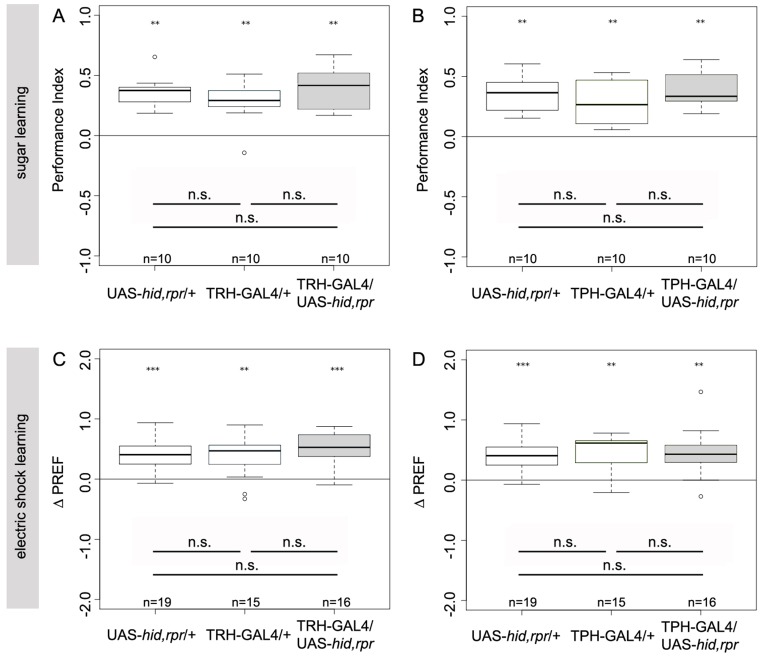
The Serotonergic Neurons of the CNS are not Necessary for Appetitive and Aversive Olfactory Learning.For testing appetitive olfactory learning, we utilized a two-group, reciprocal training design consisting of two half trials that give rise to a final performance index. Third instar larvae lacking serotonergic neurons preferred an odor that was paired with 2-M fructose (A, B). Using a single odor, non-reciprocal standard assay for aversive odor-shock learning third instar larvae lacking serotonergic neurons avoided the odor paired with pulses of electric shock (C, D). In both learning experiments, TRH-GAL4/UAS-hid,rpr larvae achieved relatively high performance scores (A) (p<0.01) (C) (p<0.001). Similar results were obtained for TPH-GAL4/UAS-hid,rpr larvae, which showed significant sugar learning (p<0.01) and electric shock learning (p<0.01). In none of the learning assays significant differences between experimental and control larvae were found. Under each boxplot of the figure for each genotype the sample size is shown; n = 10−16. Asterisks above each boxplot indicate, if the data is significantly different from zero. **<0.01; ***<0.001.